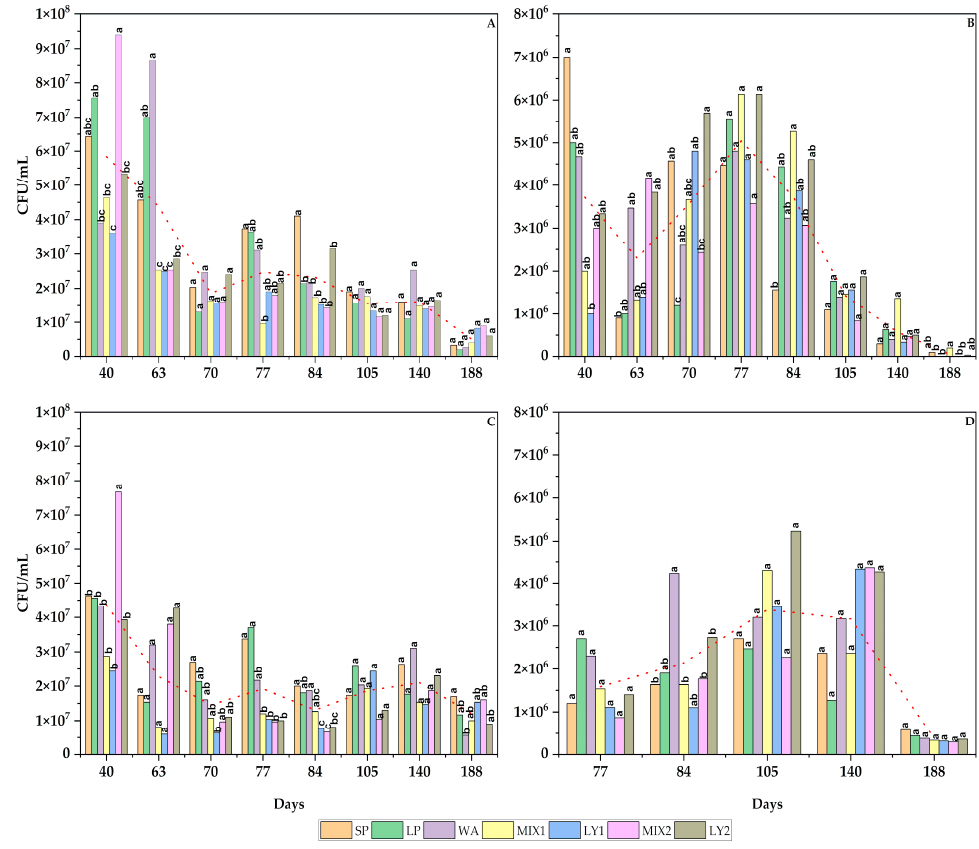
Figure 1. Lactobacilli ( A ), yeasts ( B ), total aerobic bacteria ( C ) and Enterobacteriaceae ( D ) in the brines of the different treatments. The data are expressed as means of the triplicate measurements followed by ANOVA tests. Significant differences are indicated by different letters ( p ≤ 0.05). The red dotted line represents the average microbial counts for each sampling time.